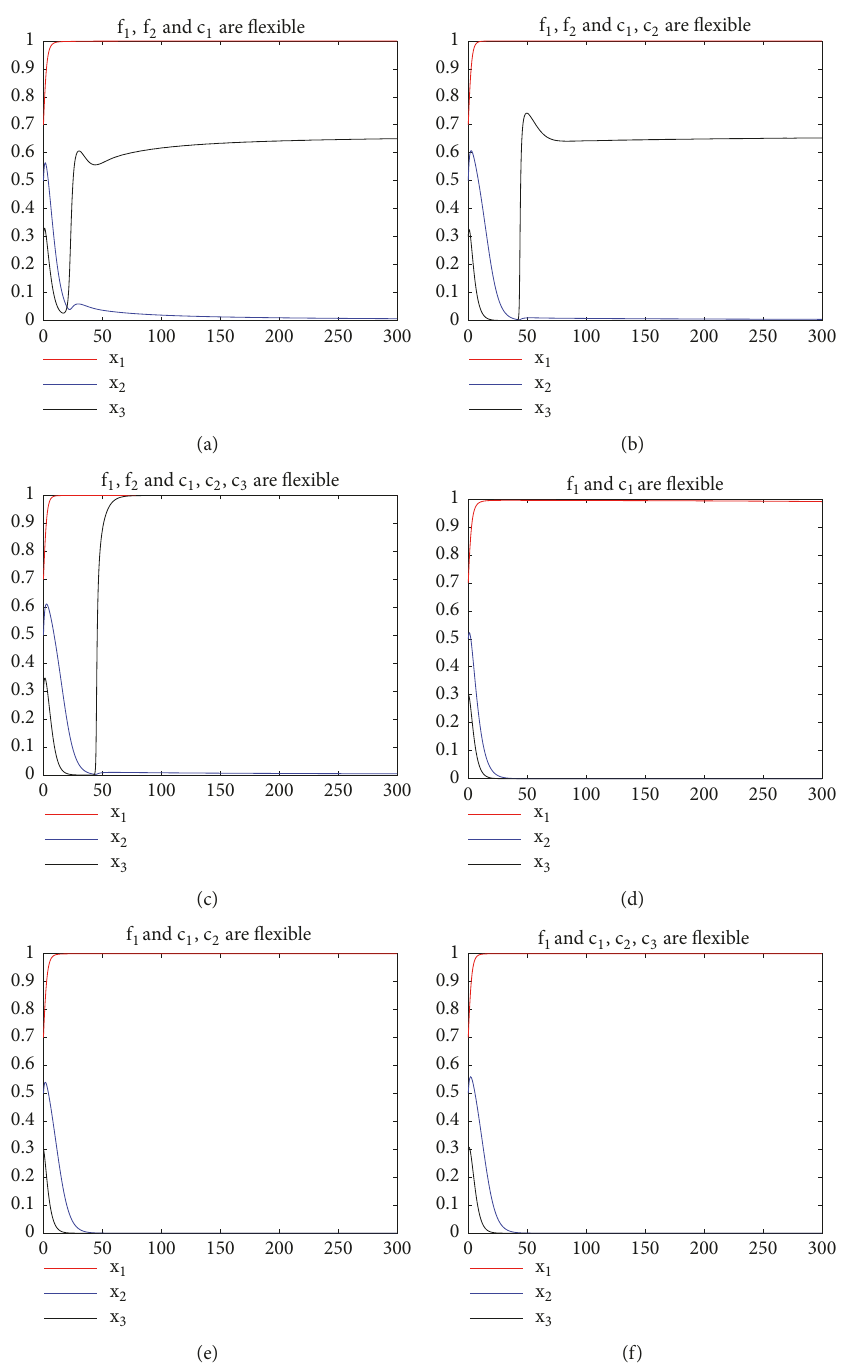
Figure 11: Time series graphs of dynamical system under combined mechanisms of incentive reward and flexible penalty. Initial value is (0.7,0.5, 0.3) 𝑃 1